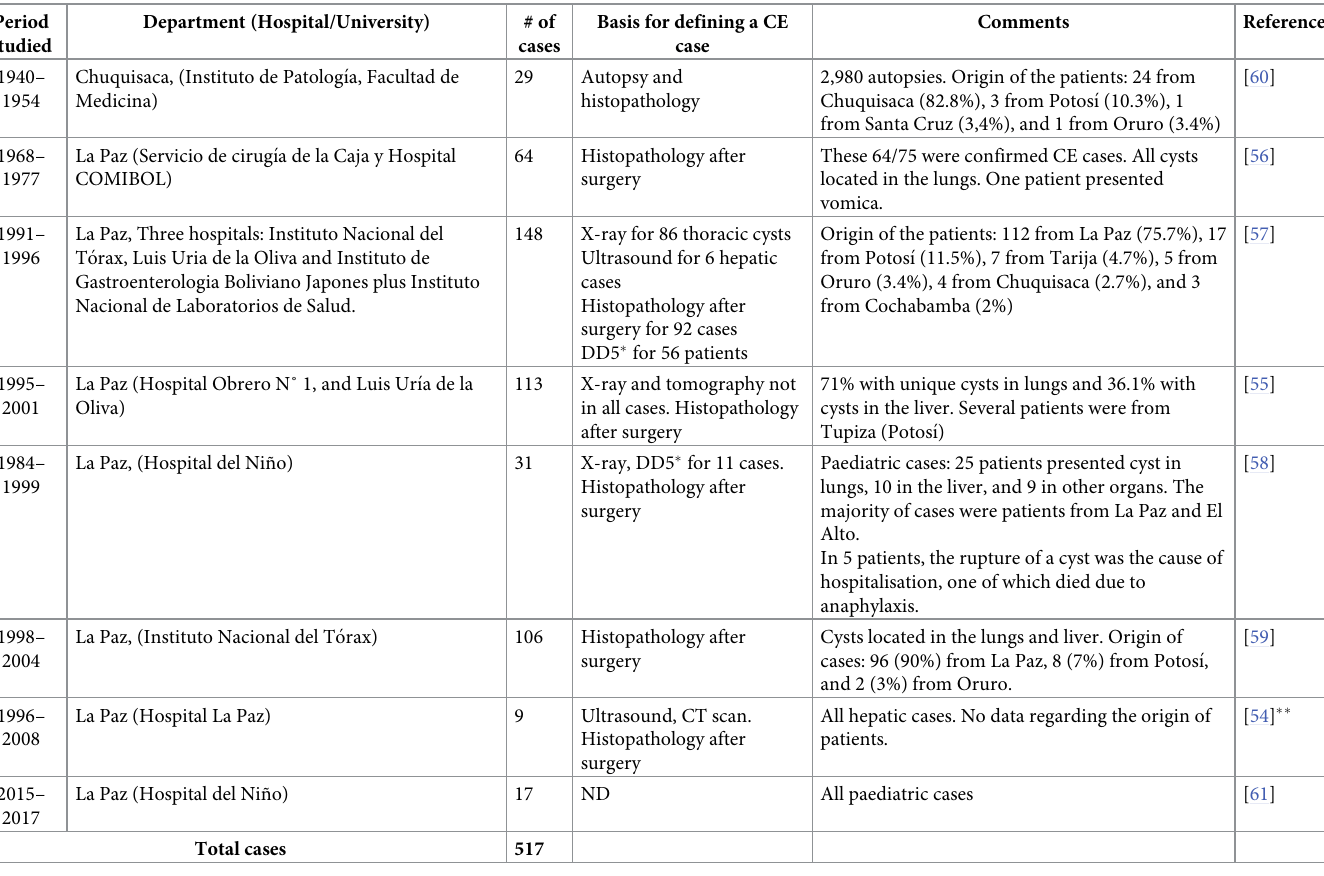
Table 2. Chronological summary of retrospective studies of human CE reported in Bolivia by department. Period studied